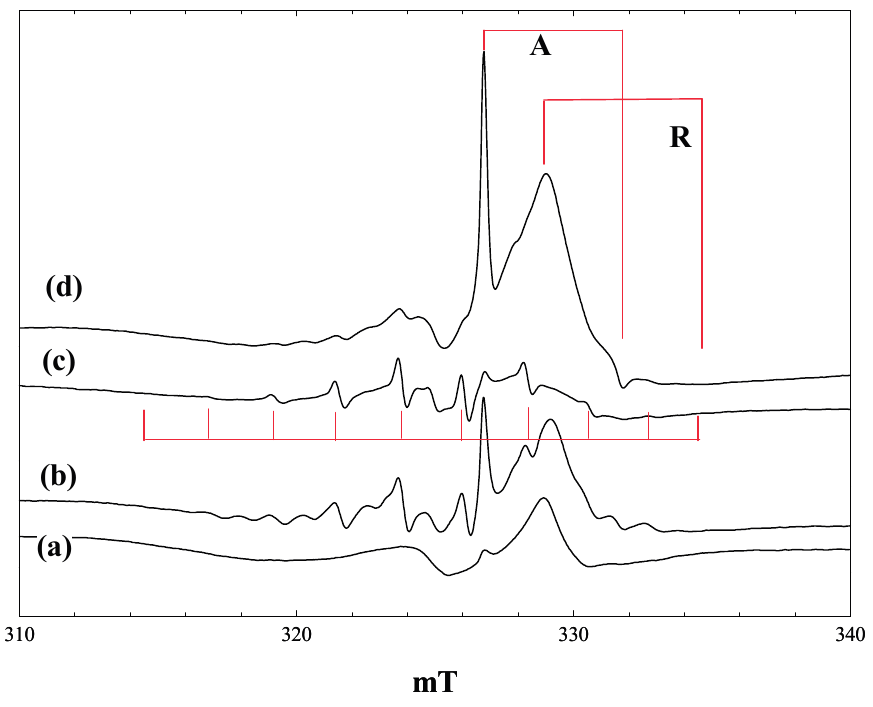
Figure 2. EPR spectra of P25 titania in a solution of pivalic acid in acetonitrile at 4 K. (a), During irradiation with low intensity 400 nm light; (b), during irradiation with high intensity 400 nm light; (c), during irradiation with high intensity broad band light; (d), after stopping